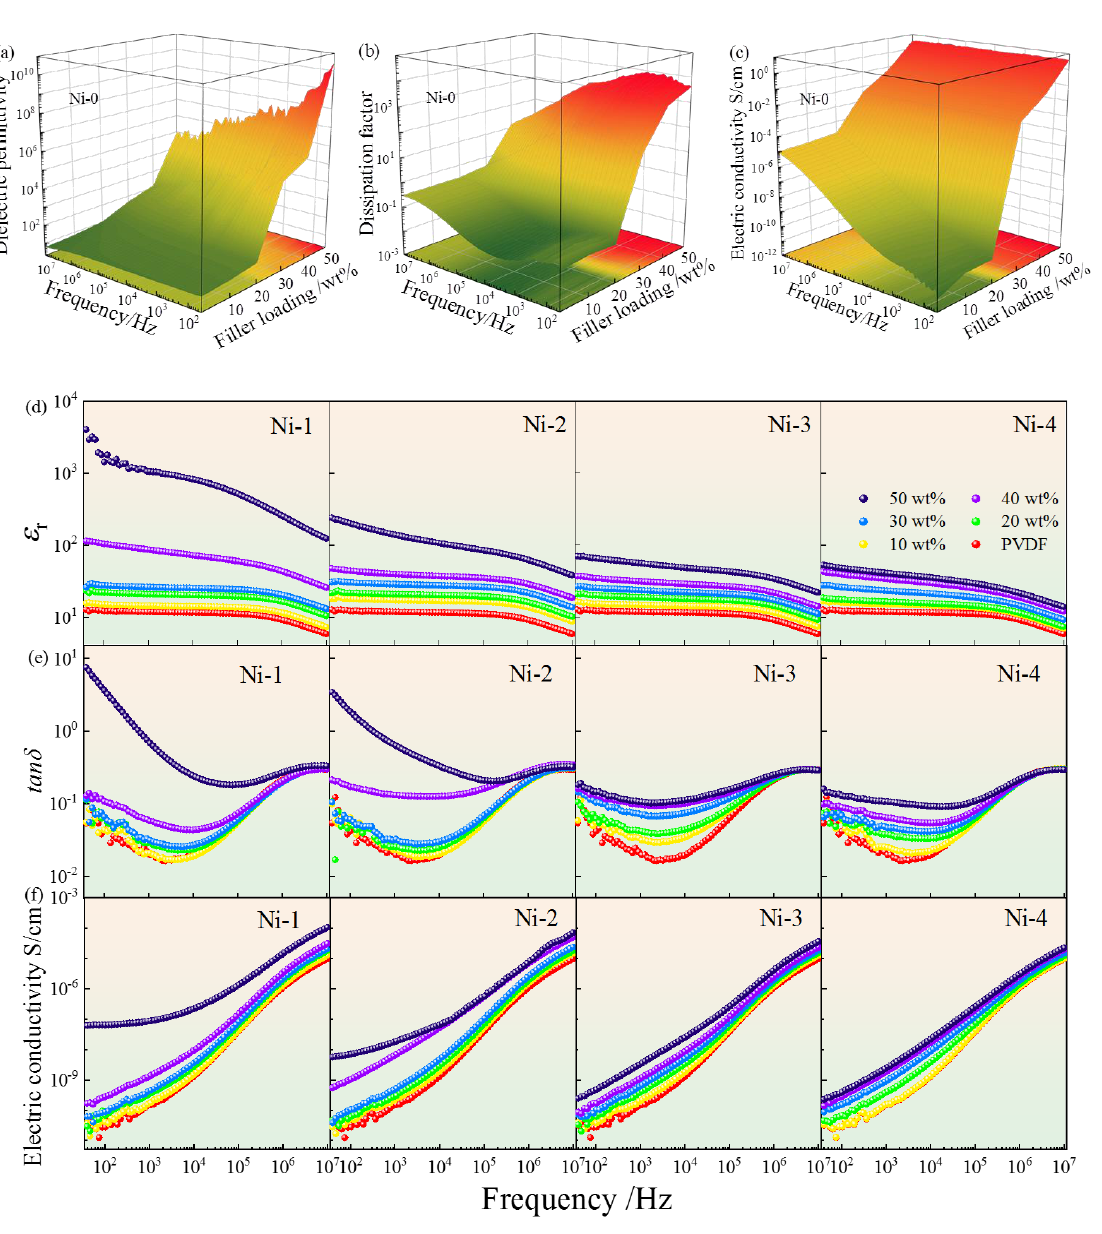
Figure 4. The frequency dependence of ( a , d ) ε r , ( b , e ) tan δ and ( c , f ) electric conductivity of Ni–0~Ni–4/PVDF composites containing various filler